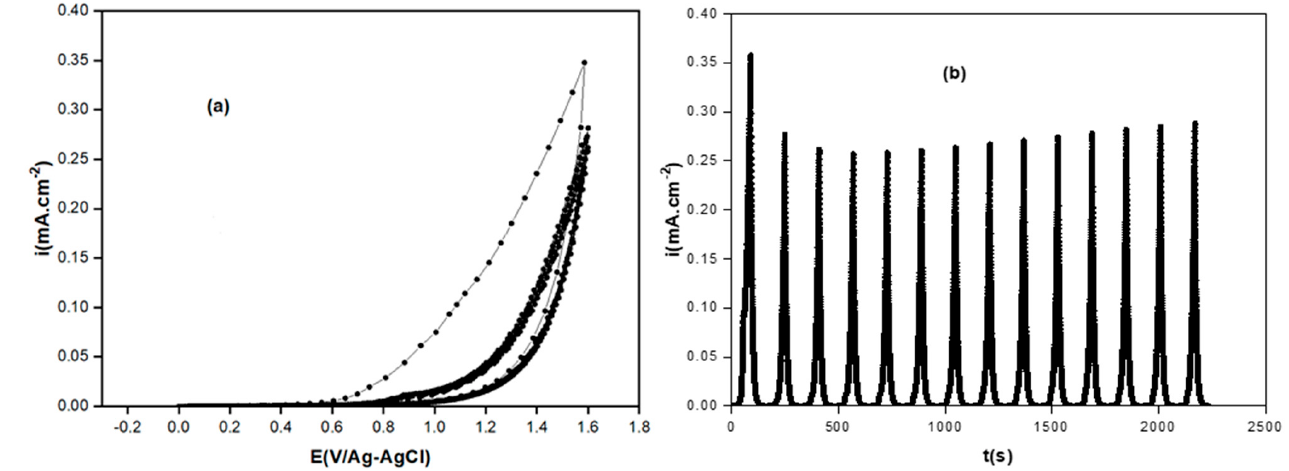
Figure 3. Electroactivity of poly-ATT recorded in pure methanol containing 0.1 M KOH, ν = 10 mV·s − 1 .